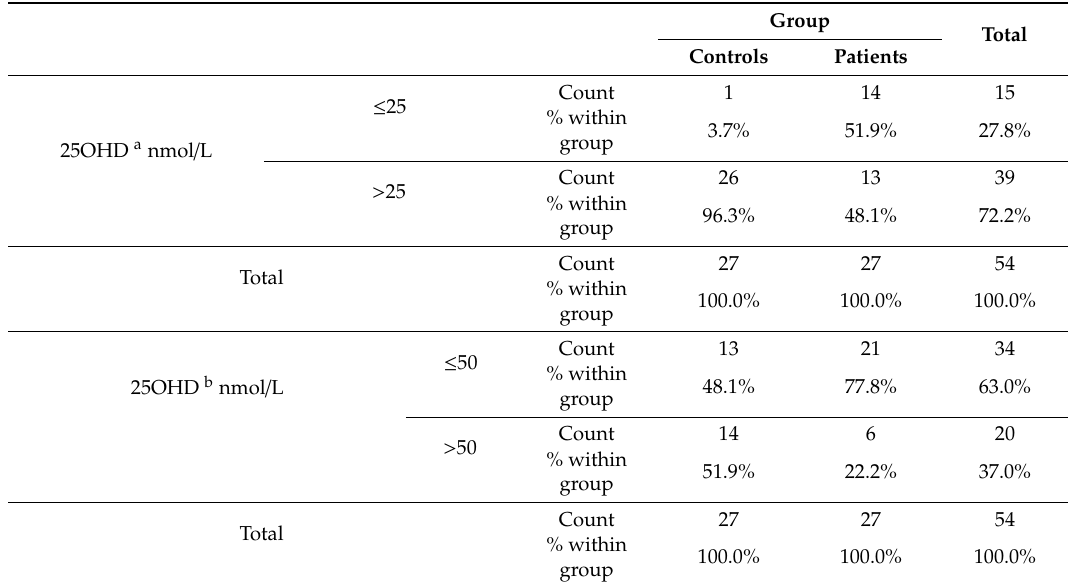
Table 3. VDD in both groups.